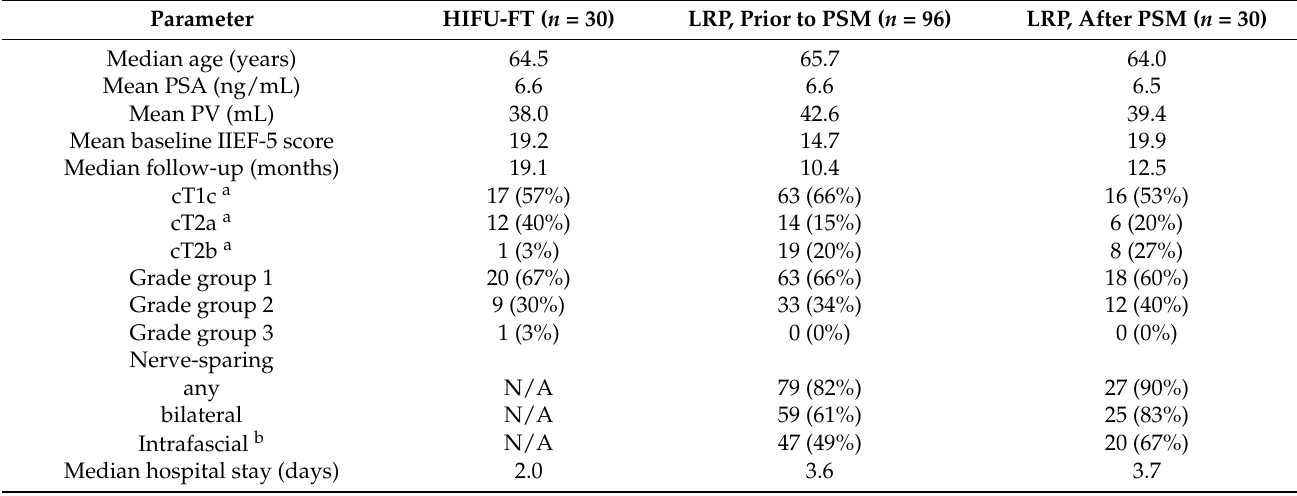
Table 1. Patient